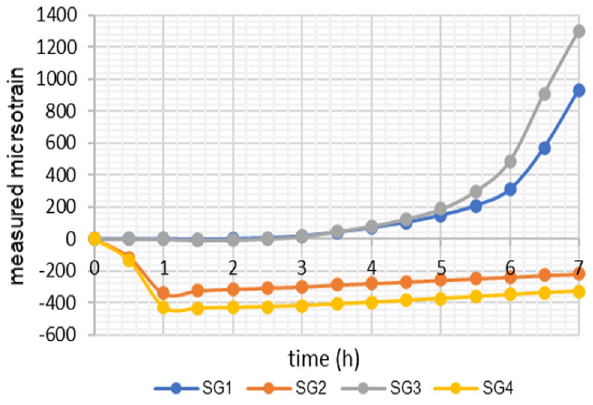
Fig. 18 Measured microstrain of specimen